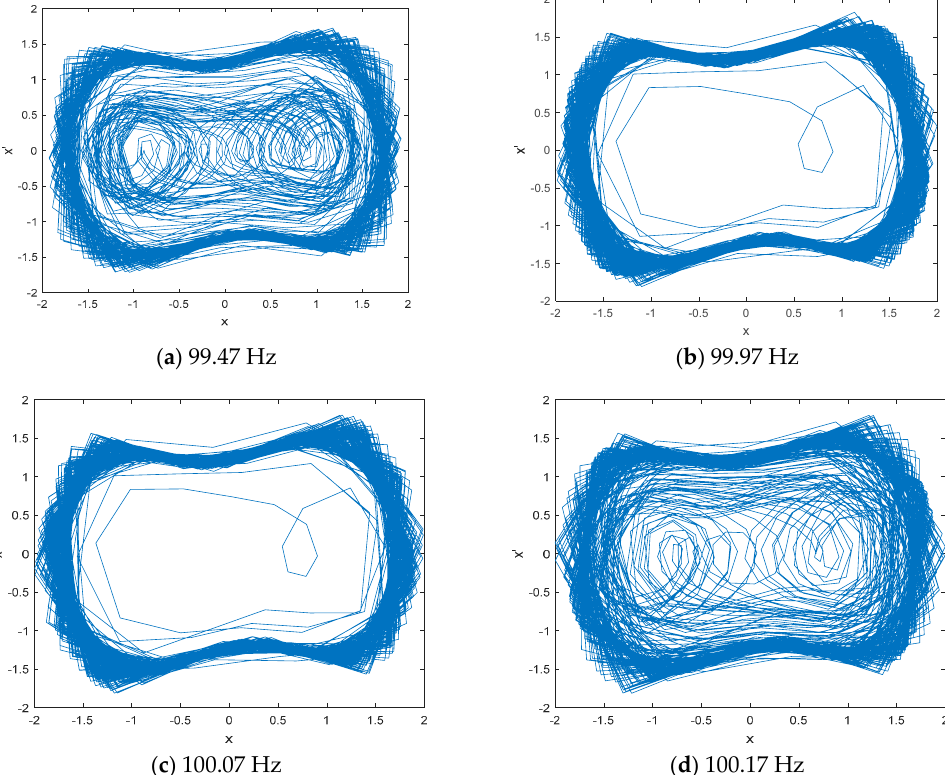
Figure 7. The phase space tracks of different driving force frequencies for IMF7.